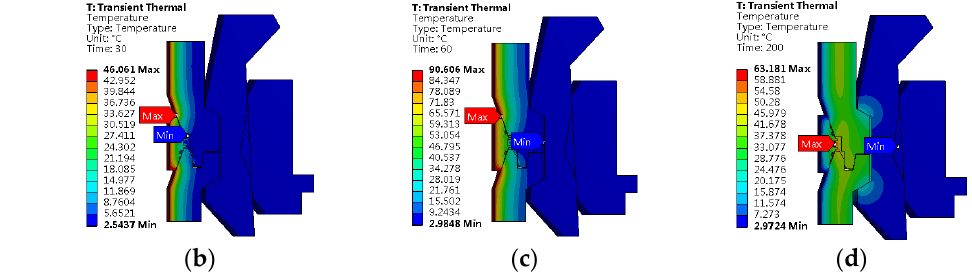
Figure 5. Transient temperature field of subsea collet connector under the working condition of temperature shock. ( a ) 10 s; ( b ) 30 s; ( c ) 60 s; ( d ) 200 s. temperature shock. ( a ) 10 s; ( b ) 30 s; ( c ) 60 s; ( d ) 200 s. Table 5. The time required for each component to generate a temperature peak under the working condition of temperature shock.